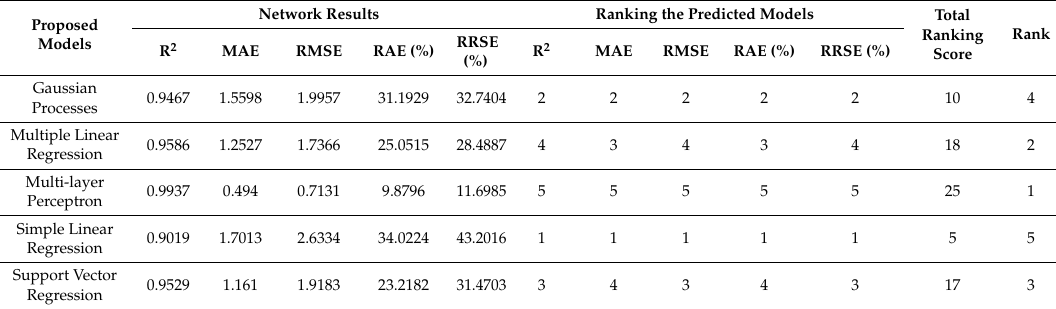
Table 1. Total ranking of training dataset in predicting the factor of safety.